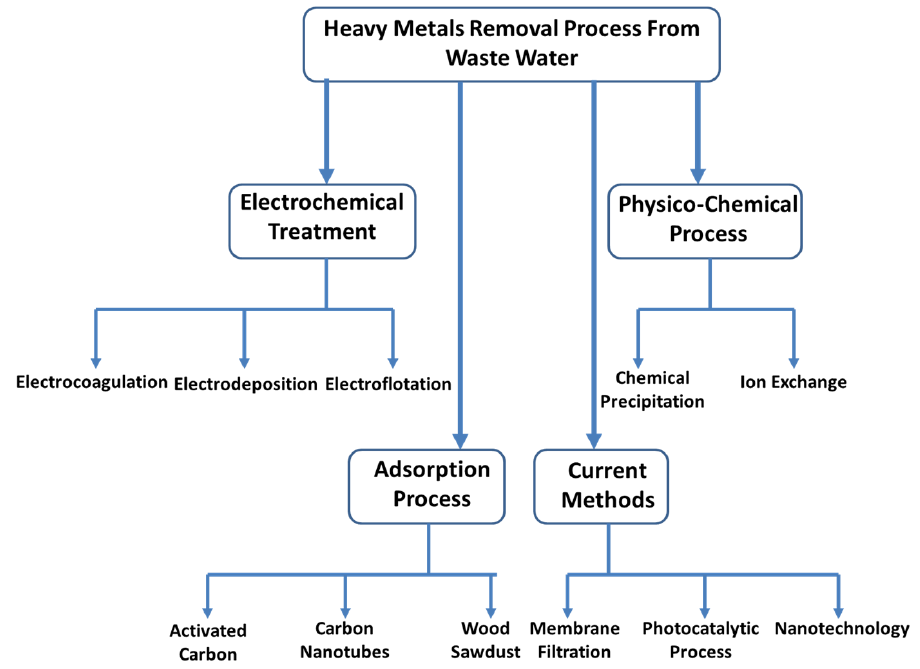
Figure 1. Tree diagram of heavy metal removal process from wastewater.